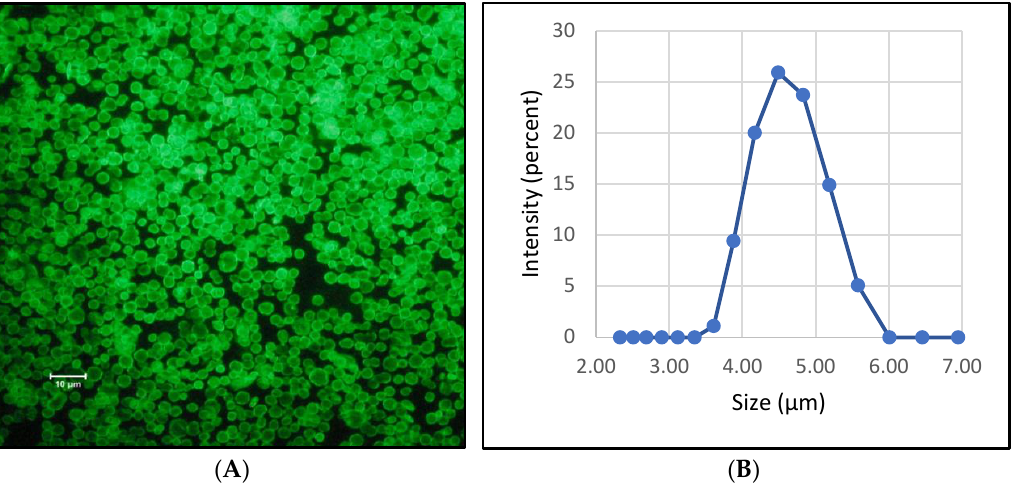
Figure 5. Image ( A ) and size distribution by intensity ( B ) of polyelectrolyte microcapsules with encapsulated bacteriophages. ( A ) Fluorescence microscopy image of PMCs with encapsulated FITC- labeled bacteriophages; ( B ) size distribution by intensity of PMCs with encapsulated bacteriophages.